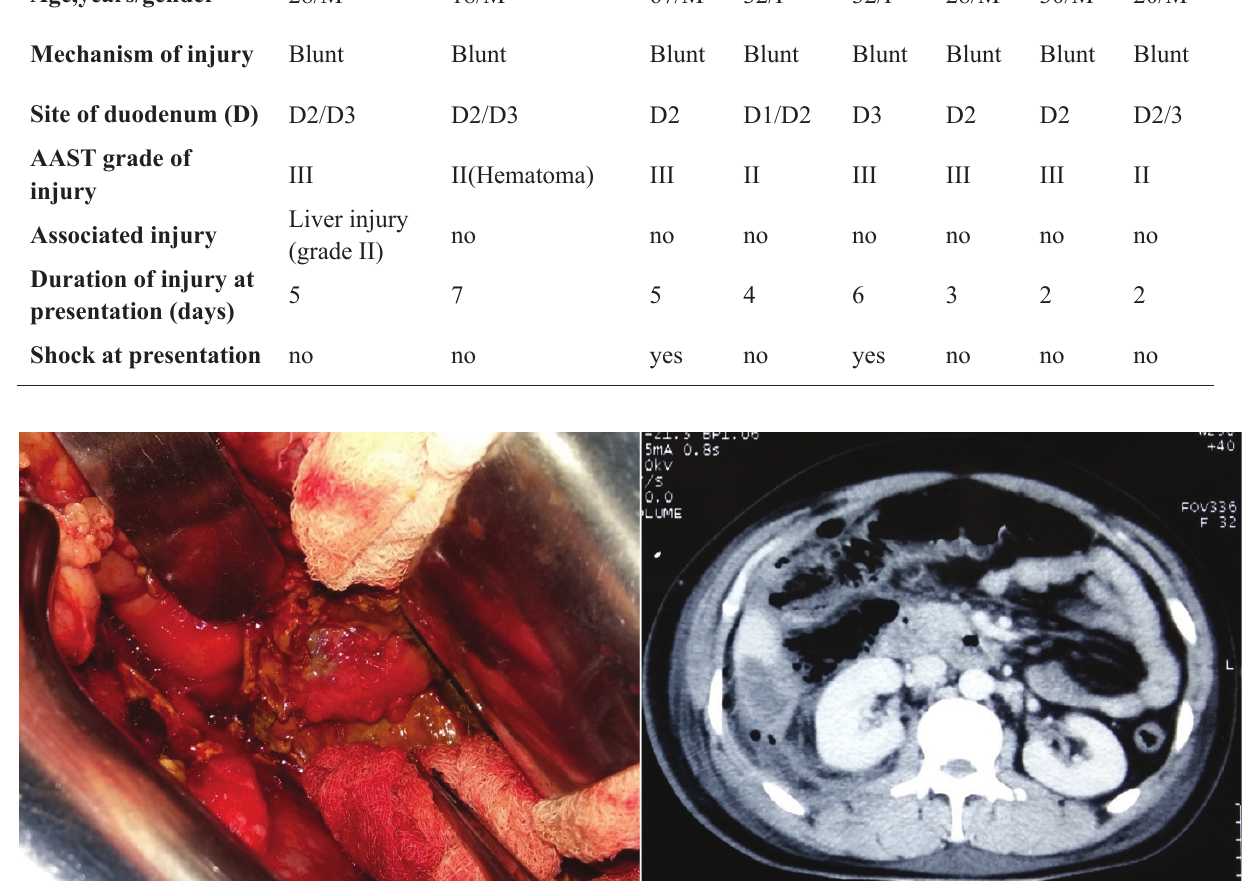
Figure 2: Contrast CT abdomen (right) showing extensive periduodenal and retroduodenal air, suggesting duodenal perforation. Note (left) the multiple perforations on the second and third parts of the duodenum covering three- fourth of the circumference of the